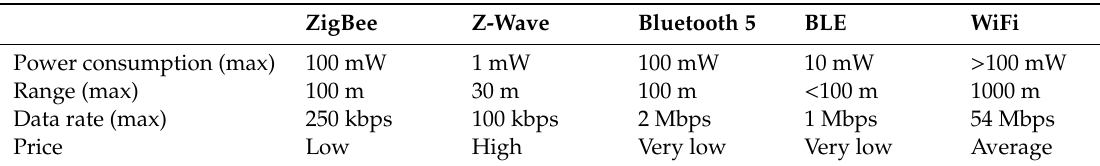
Table 1. Comparison between available wireless technologies: ZigBee, Z-Wave, Bluetooth 5, BLE, and WiFi [15–17].